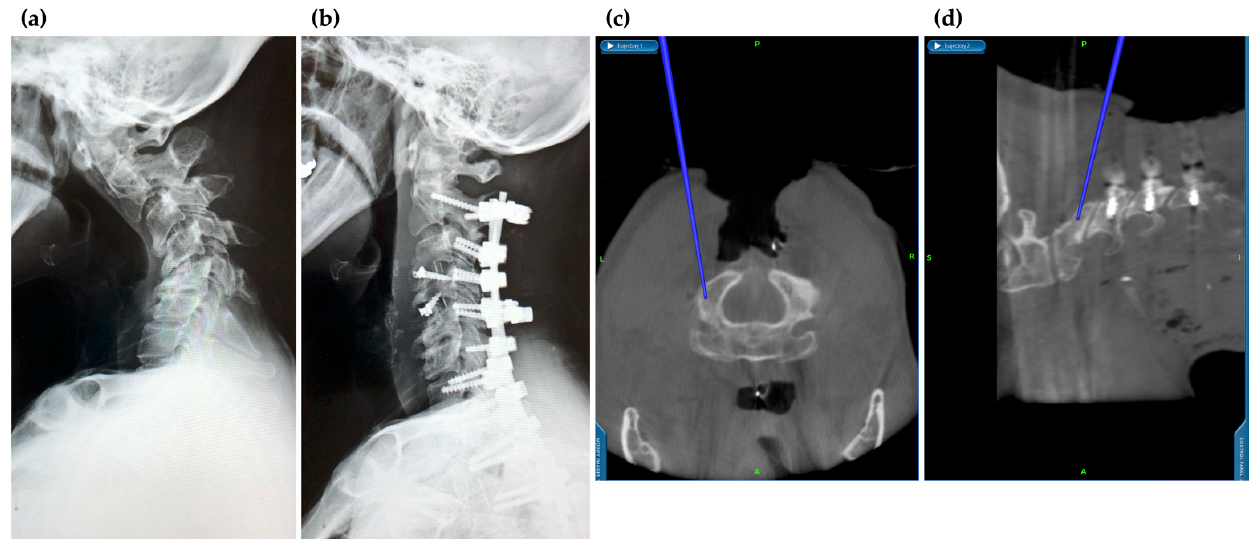
Figure 3. Application of navigation in cervical spine surgery. The surgical procedure can be performed safely while checking the vertebral artery running in the vicinity. Because of the high flexibility of the cervical spine, intraoperative alignment changes must be carefully monitored. ( a ) Pre-operative X-ray; ( b ) post-operative X-ray; ( c ) intraoperative axial; and ( d ) intraoperative sagittal views on navigation monitor.